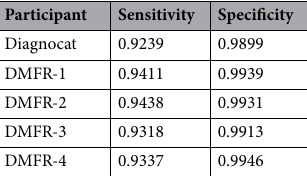
Table 2. Cross-condition sensitivity and specificity for the system and dentomaxillofacial radiology examiners.